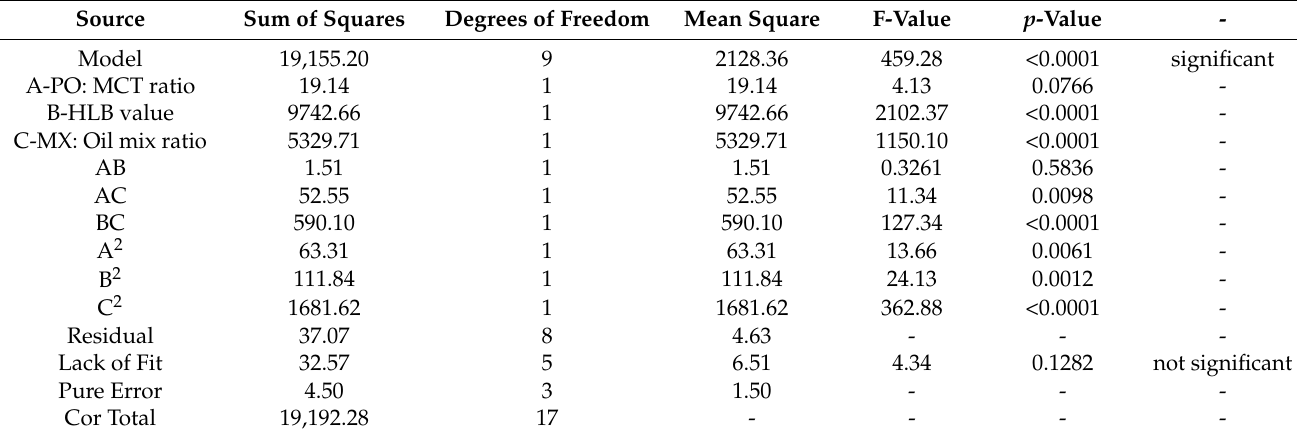
Table 5. ANOVA data for particle size of MX-PO-SNEDDS formulations prepared in various experimental runs.